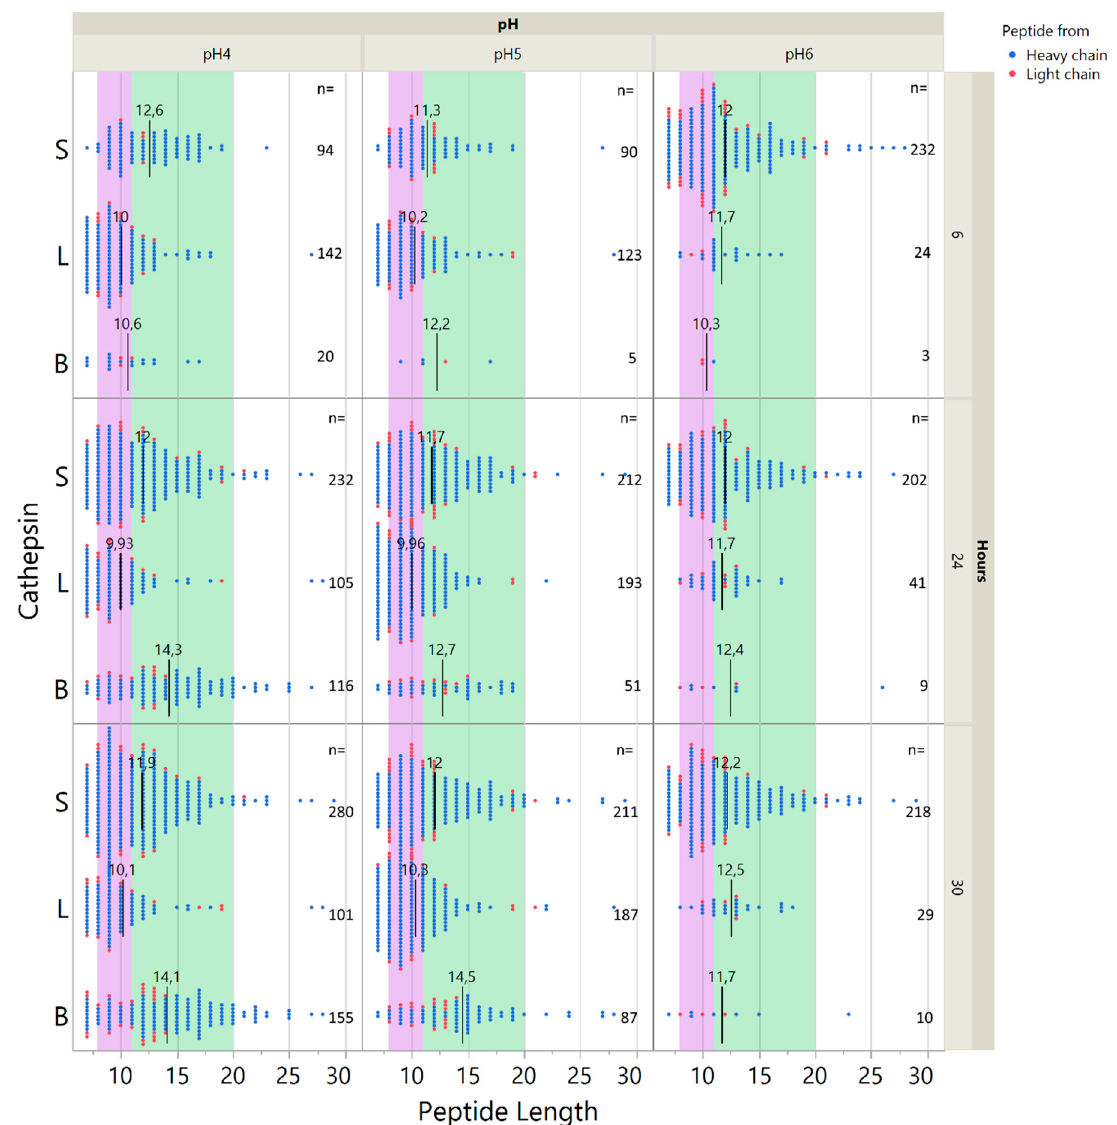
Figure 7. Adalimumab digestion by cathepsin S, L and B at pH 4, 5, and 6. Distribution of peptide lengths after digestion of 2400 nM adalimumab with either cathepsin B, L, S at 6, 24, or 30 h at pH 4, 5, or 6. Each data point represents one identified peptide at the given time point. Black lines with annotations indicate the mean size of peptides. Purple and green areas indicate peptide sizes fitting HLA class I and II, respectively. (Note: For pH 6, the data for cathepsins S and B are the same as in Figure 3B).